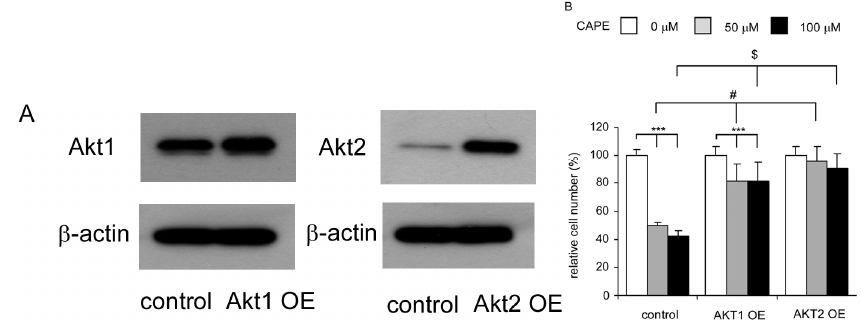
Figure 6. Overexpression of Akt1 and Akt2 in TW2.6 cells rescued inhibition of cell proliferation caused by CAPE treatment. ( A ) Protein expression of Akt1 and Akt2